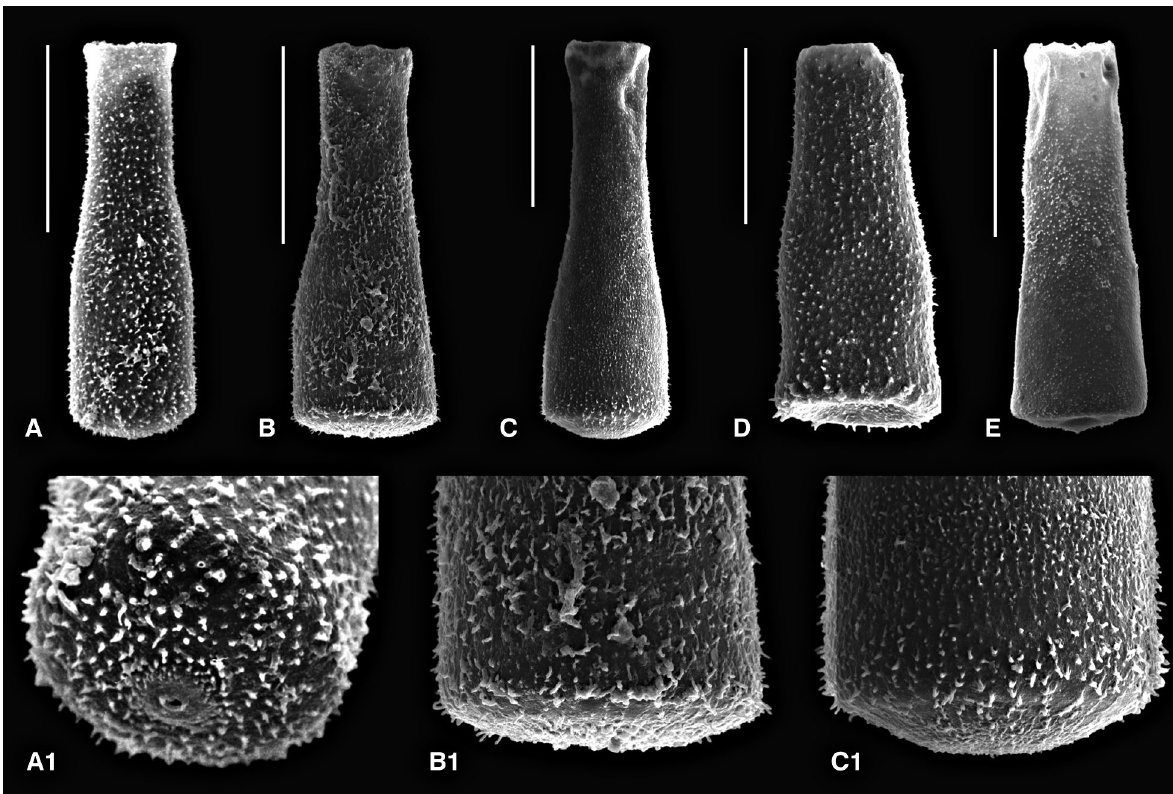
Fig. 4. Belonechitina intonsa sp. nov. A , A1 , holotype, GIT 544-41, Kerguta (565): 157.1 m (208  67  42 µm); B , B1 , GIT 718-10 Männamaa (F-367): 168.1 m (195  72  45 µm); C , C1 , GIT 718-11, Männamaa (F-367): 168.1 m (241  77  51 µm); D , GIT 718-12, Belonechitina cf. intonsa , Vihterpalu (1103): 32.0–32.1 m (196  95  50 µm); E , GIT 718-13, Saare (K-20): 109.2–109.3 m (201  73  46 µm). The scale bars correspond to 100